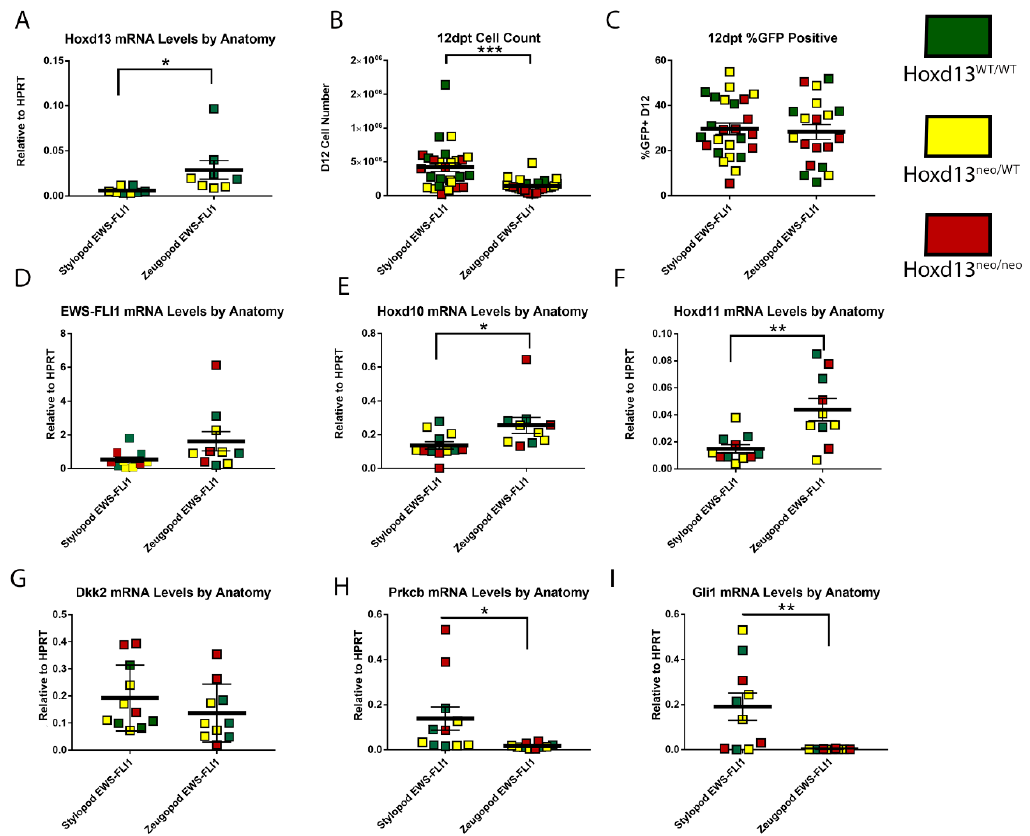
Figure 5. Loss of Hoxd13 does not impact EWS-FLI1 induced transformation by twelve days post transduction (dpt). ( A ) Hoxd13 mRNA levels relative to HPRT. ( B ) Cell count at 12 dpt. ( C ) Flow cytometry for GFP expression at 12 pt. ( D ) EWS-FLI1 mRNA levels relative to HPRT. ( E ) Hoxd10 mRNA levels relative to HPRT. ( F ) Hoxd11 mRNA levels relative to HPRT. ( G ) Dkk2 mRNA levels relative to HPRT. ( H ) Prkcb mRNA levels relative to HPRT. ( I ) Gli1 mRNA levels relative to HPRT. Green Hoxd13 WT/WT , Yellow Hoxd13 neo/WT , and Red Hoxd13 neo/neo . *** p ≤ 0.001; ** p ≤ 0.01; * p ≤ 0.05. Error bars are SEM.